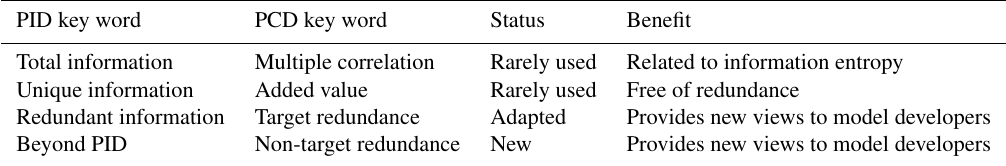
Table 1. PCD terms. PID key word PCD key word Status Benefit Total information Multiple correlation Rarely used Related to information entropy Unique information Added value Rarely used Free of redundance Redundant information Adapted Provides new views to model